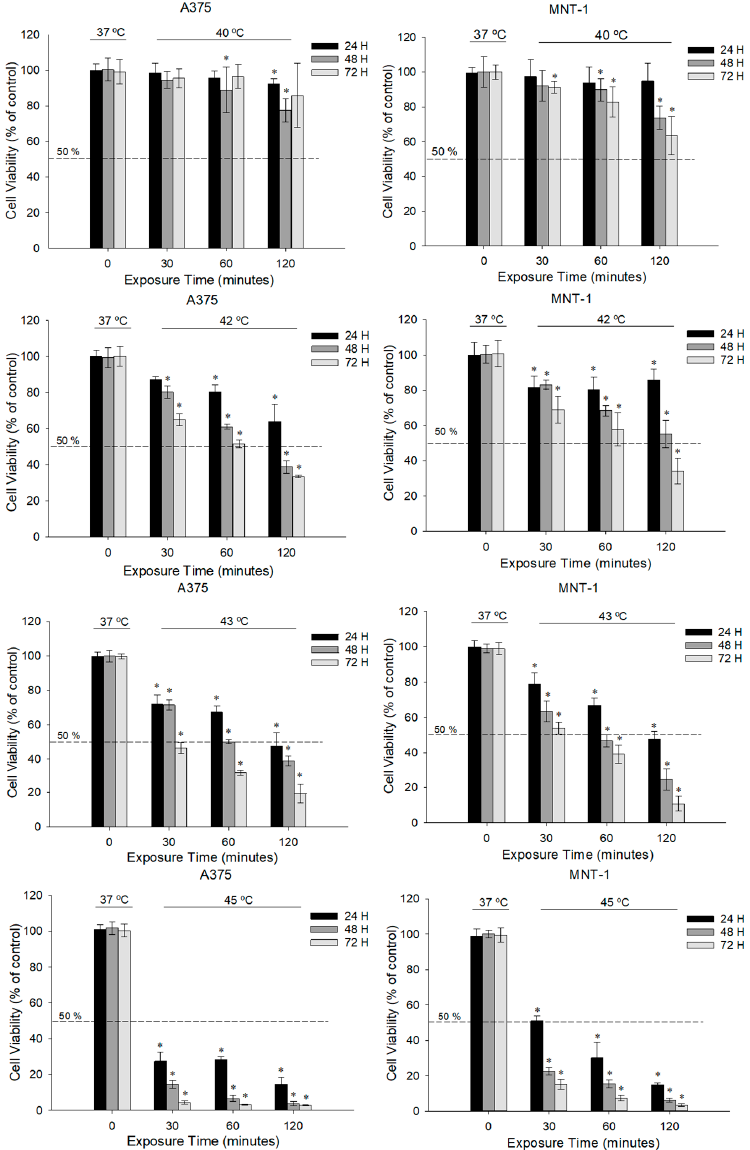
Figure 1. Effect of hyperthermia on the viability of A375 and MNT-1 cells. Cells were exposed to 40 ◦ C, 42 ◦ C, 43 ◦ C or 45 ◦ C for 30, 60, and 120 min and cell viability was determined following